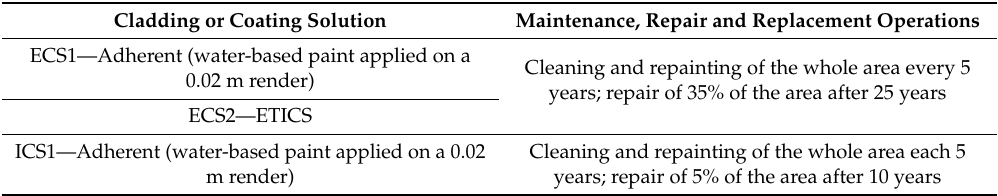
Table 2. Maintenance, replacement, and repair operations of the external cladding and internal coatings of the external wall solutions evaluated.